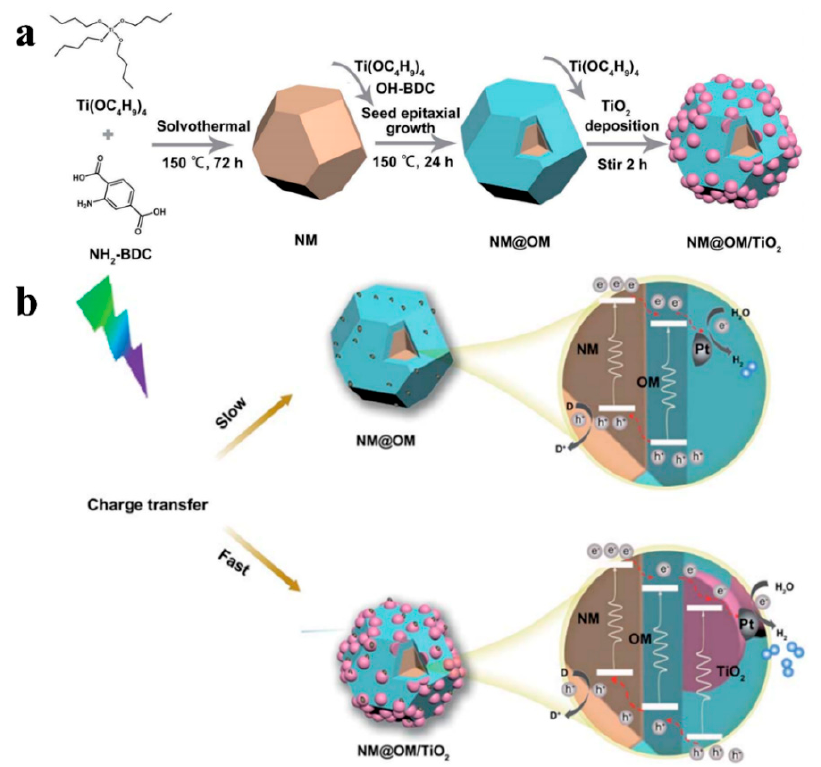
Figure 11. ( a ) The preparation procedure of the NM@OM/TiO 2 dual heterojunction. ( b ) The possible mechanism for photocatalytic hydrogen evolution on NM@OM/TiO 2 under full-spectrum illumination. Reproduced with permission from Ref. [74].